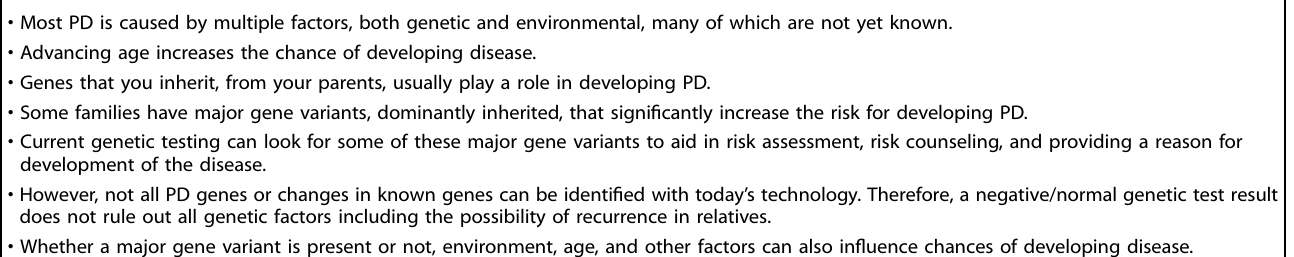
Table 1. Talking points to share with patients with late-onset Parkinson ’ s disease